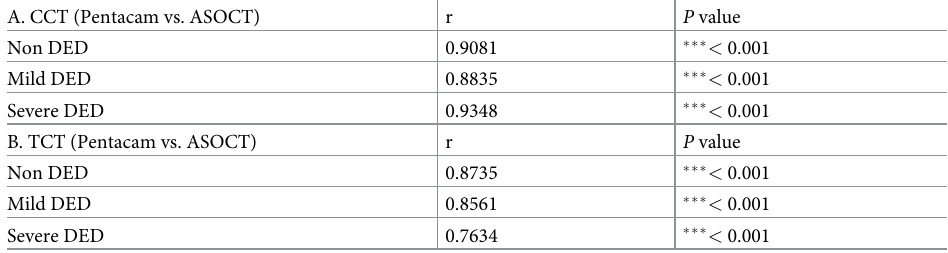
Table 2. Correlation coefficients between the Pentacam and ASOCT measurements for CCT and TCT per Group.